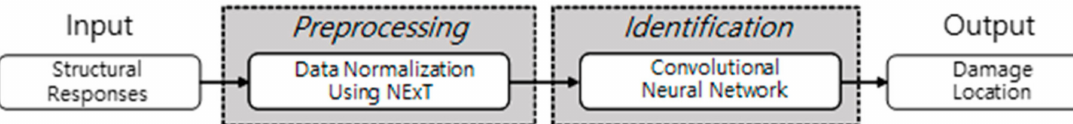
Figure 1. Proposed damage identification